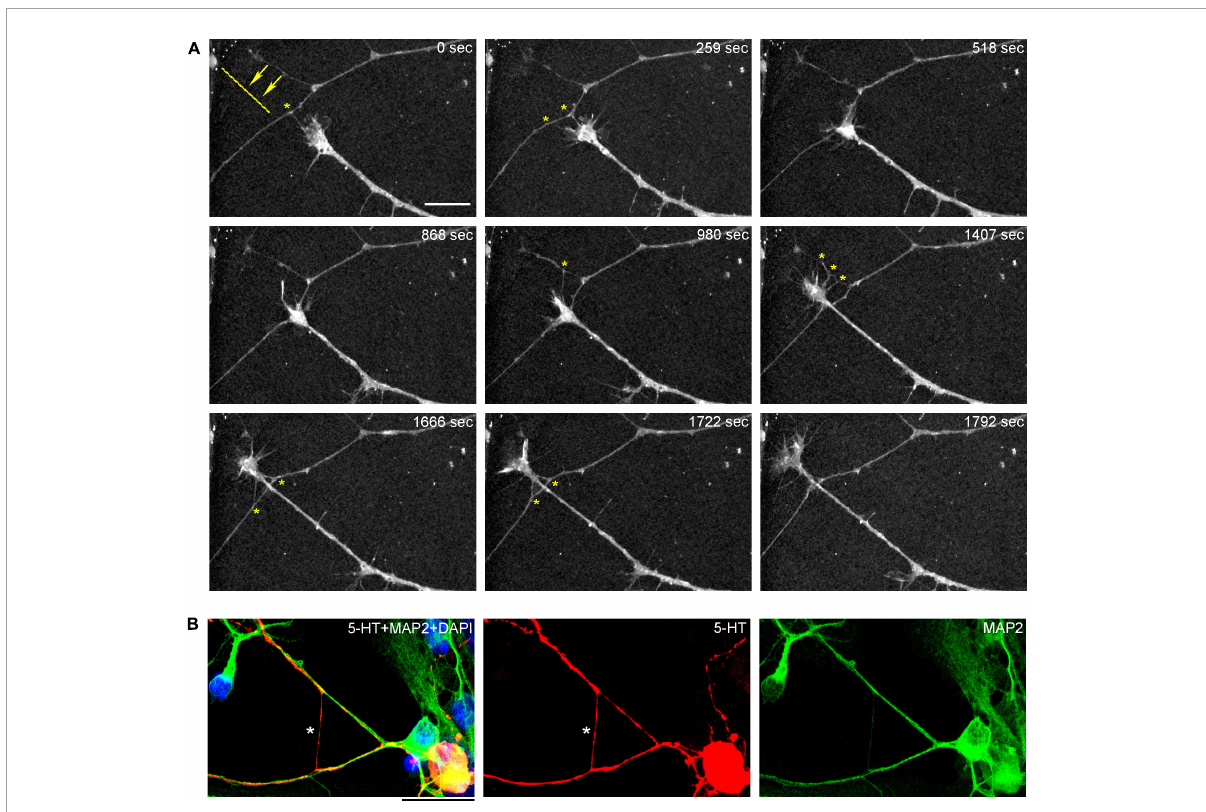
FIGURE8 (A) The dynamics of a growth-cone region in a primary midbrain culture (monolayer at DIV 5), visualized with time-lapse holotomography ( Supplementary Video 3 ). A transition from one neurite branch to another is shown (some key adhesion points are marked with asterisks). The arrows with the dashed line indicate the spatial shift of the top branch, as the growing axon generates sufficient force to line it up with its current growth axis. To emphasize key transitions, time points are not evenly spaced. This imaging supports the interpretation of the dynamics that may underly the confocal microscopy data, but the recorded axons are not labeled and may not be serotonergic. Scale bar = 10 µ m. (B) A similar transition (asterisk) in a primary midbrain culture (monolayer at DIV 2), visualized with immunocytochemistry for 5-HT (red) and MAP2 (green) and imaged with high-resolution confocal microscopy. Cell nuclei are stained blue (DAPI). Scale bar = 20 µ